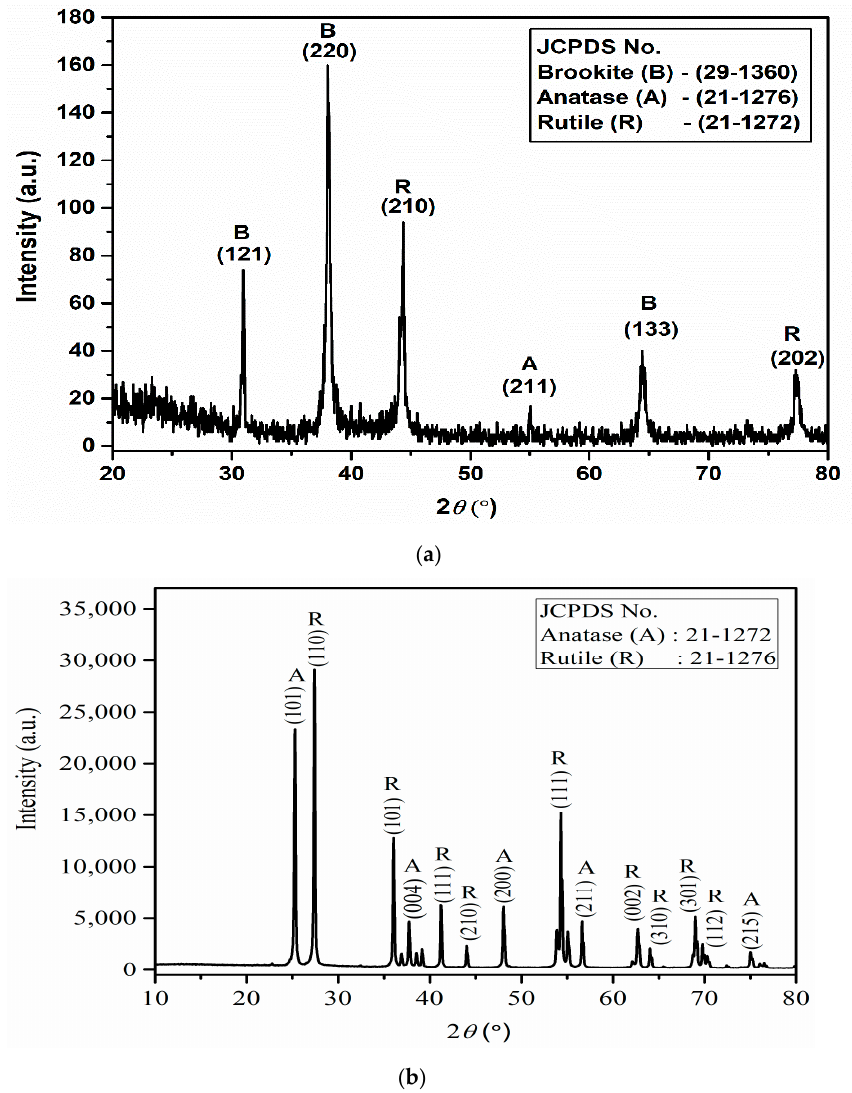
Figure 3. XRD spectra of ( a ) TiO 2 nanospheres and ( b ) rGO/TiO 2 nanocomposites.